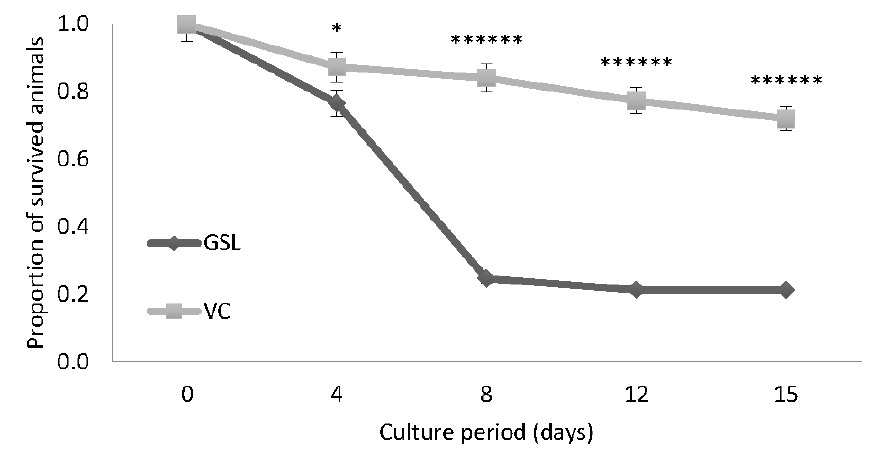
Figure 3. Experiment 1. Proportion of surviving Artemia cultured in Lake Bunyampaka saline water at 30 g L − 1 for 15 days; GSL (A) and VC (B). Values are presented as means ± SE. ( n = 3), * p < 0.05, ** p < 0.01, *** p < 0.001, **** p < 0.0001, ***** p < 0.00001, ****** p < 0.000001 vs. the corresponding treatment group. GSL: Great Salt Lake, CGSL: Control for Great Salt Lake, VC: Vinh Chau, CVC: Control for Vinh Chau.